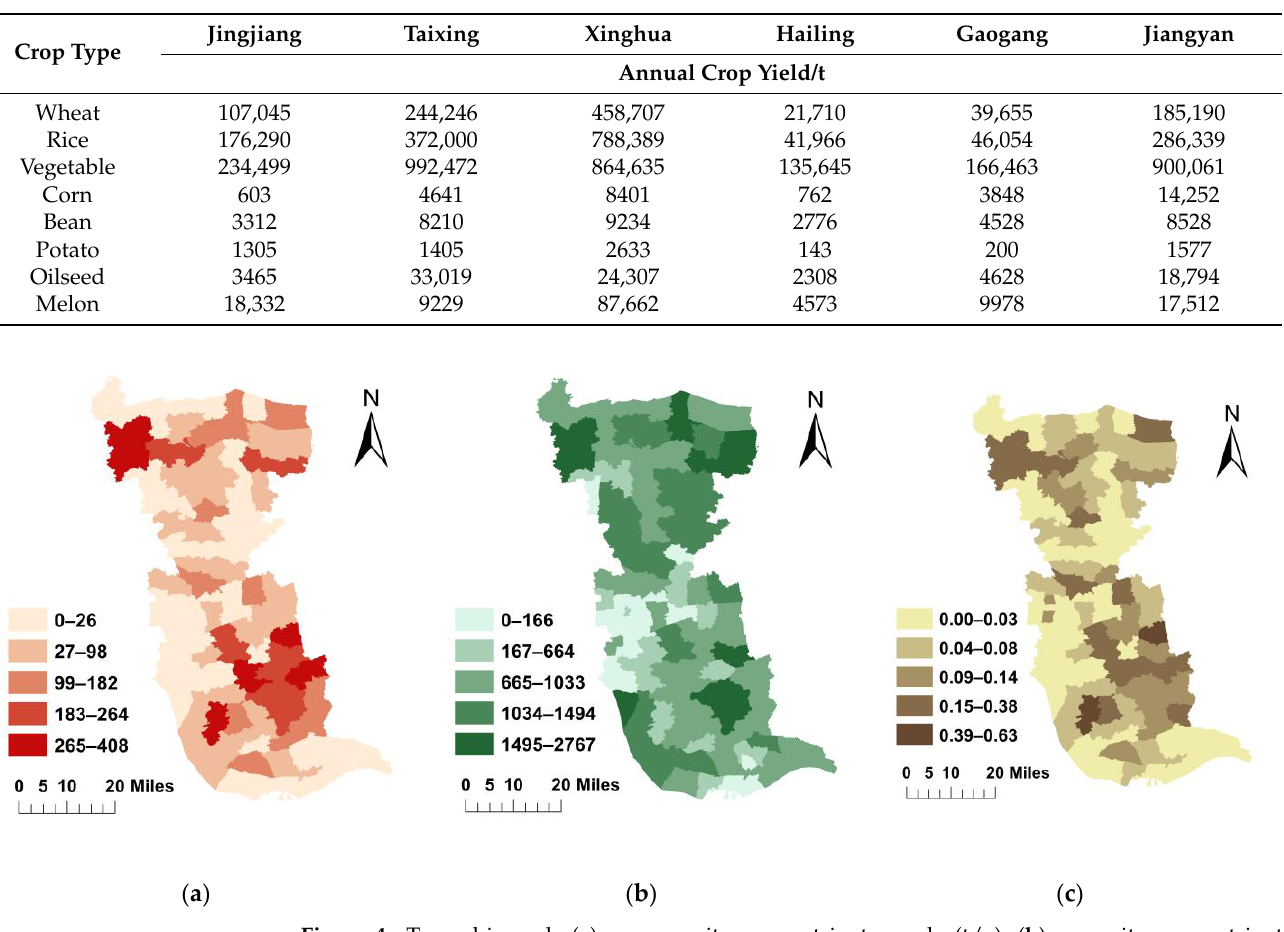
Figure 4. Township-scale ( a ) manure nitrogen nutrient supply (t/a); ( b ) crop nitrogen nutrient demand (t/a); ( c ) livestock land carrying capacity (calculated as 50% of total nutrients from livestock manure to agricultural fertilizer).